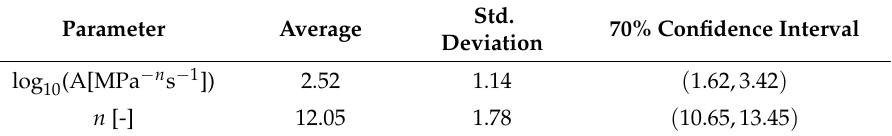
Table 2. Results of the inverse identification—Tensile creep.